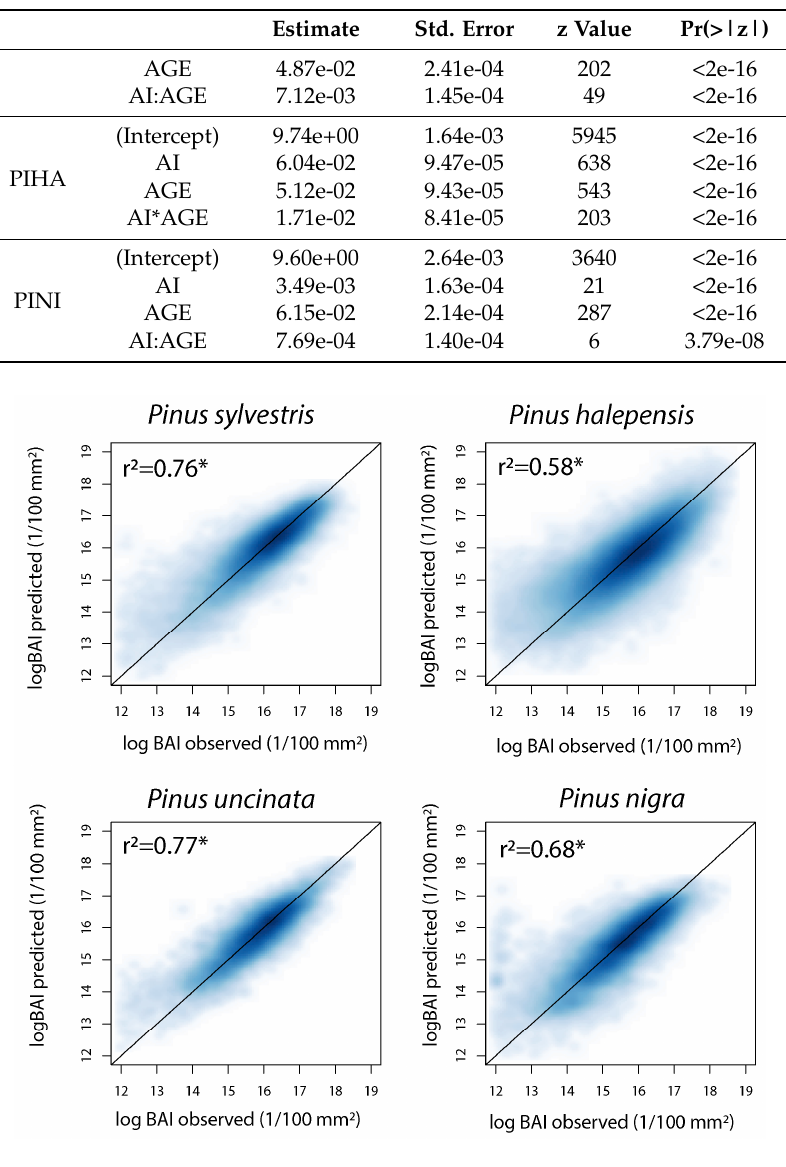
Figure 4. Basal Area Index predicted (log) using the Generalized Linear Mixed-Effects models versus the observed BAI (log). The explained variance of the models (r 2 ) is shown. The asterisk indicates a significance level p < 0.001.